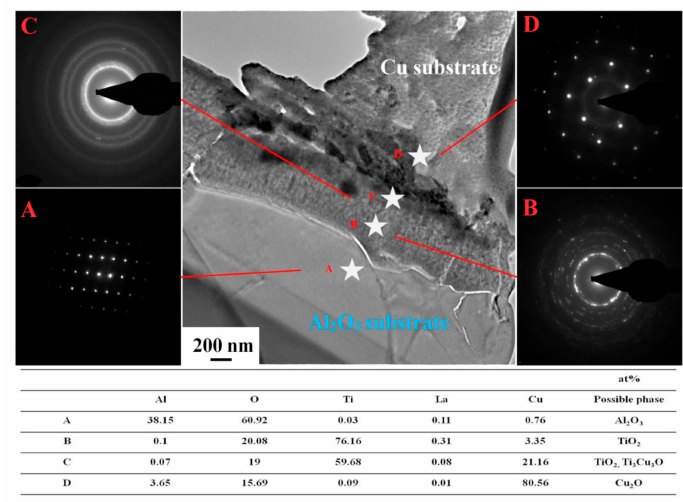
Figure 4. TEM images and energy-dispersive X-ray spectroscopy (EDS) results showing the heterogeneous bonding of alumina and copper substrates fabricated at a process temperature of 350 ◦ C.